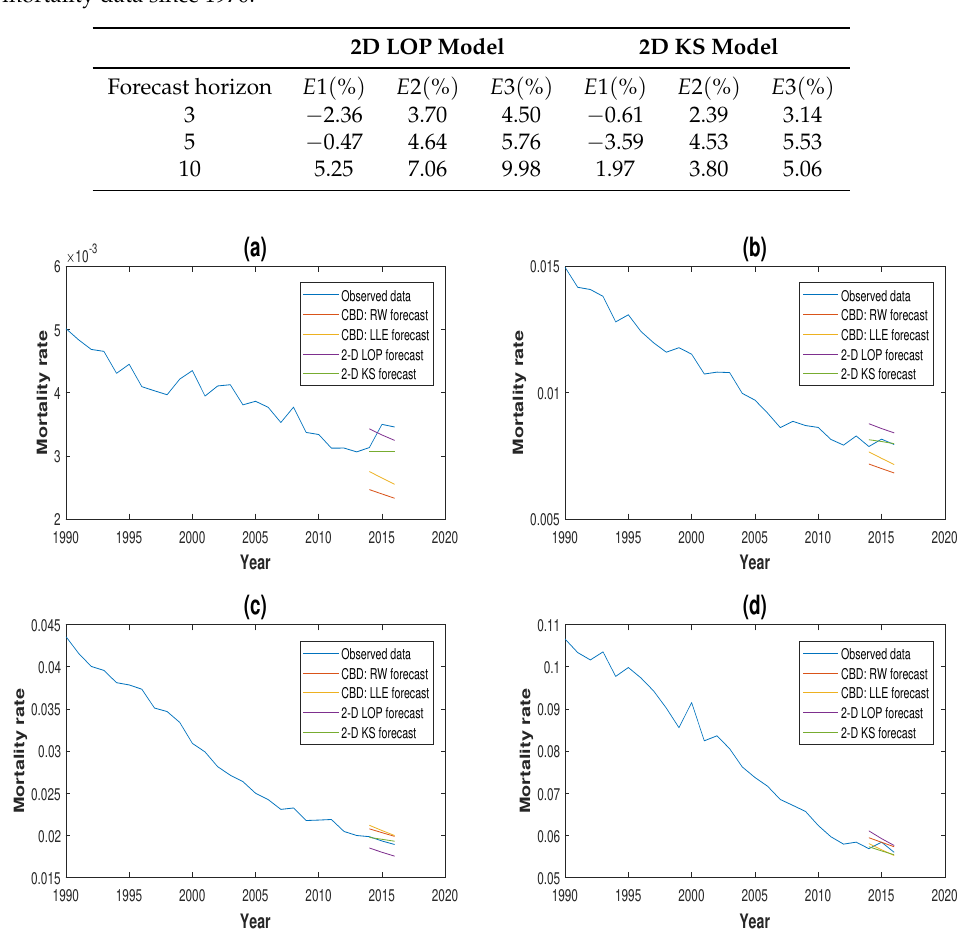
Table 5. Forecasting results of the 2D LOP model and the 2D KS model for GB males aged 50–89 based on mortality data since 1970.